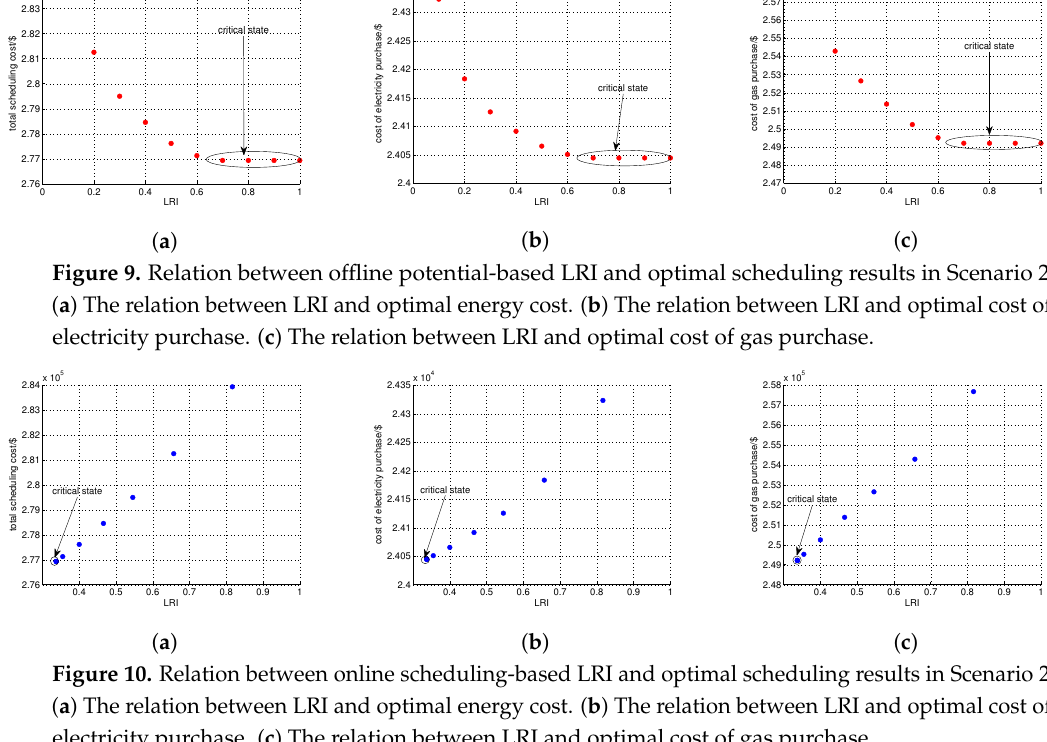
Figure 10. Relation between online scheduling-based LRI and optimal scheduling results in Scenario 2. ( a ) The relation between LRI and optimal energy cost. ( b ) The relation between LRI and optimal cost of electricity purchase. ( c ) The relation between LRI and optimal cost of gas